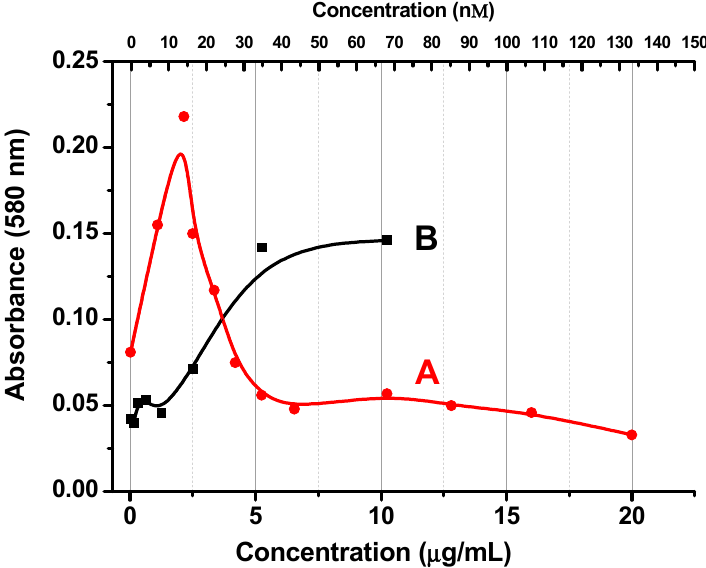
Figure 2. Flocculation curves of GNP conjugates with antibodies. ( A ; red curve), after adding Mab 2H2F6 and 10% NaCl. ( B ; black curve), after adding Mab2H3C6.